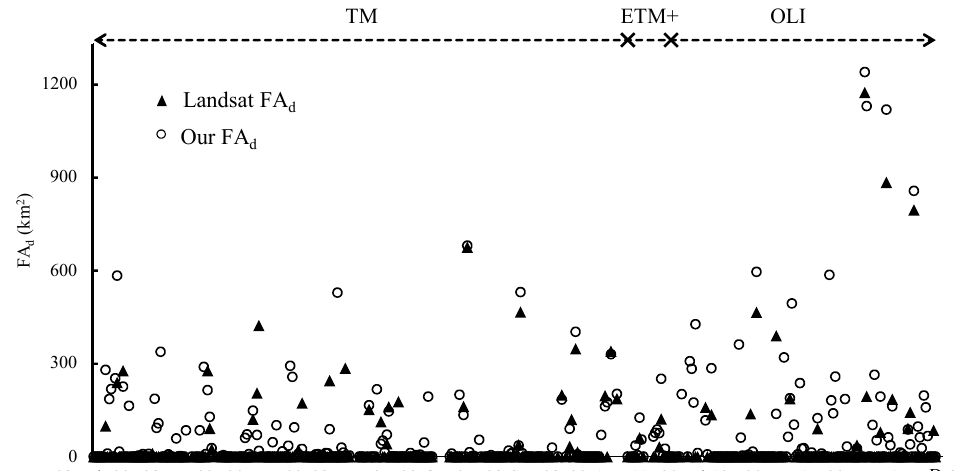
Figure 6. Comparison between our daily cyanobacteria bloom areas (FA d ) and that of Landsat interpretation.